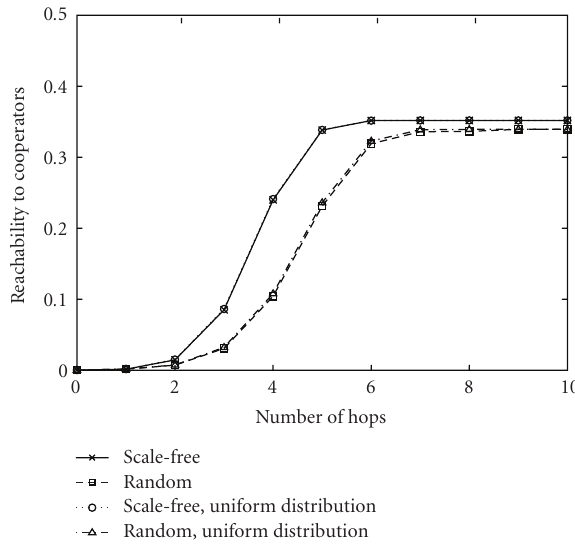
Figure 8: Reachability to cooperators ( K = 100, m =